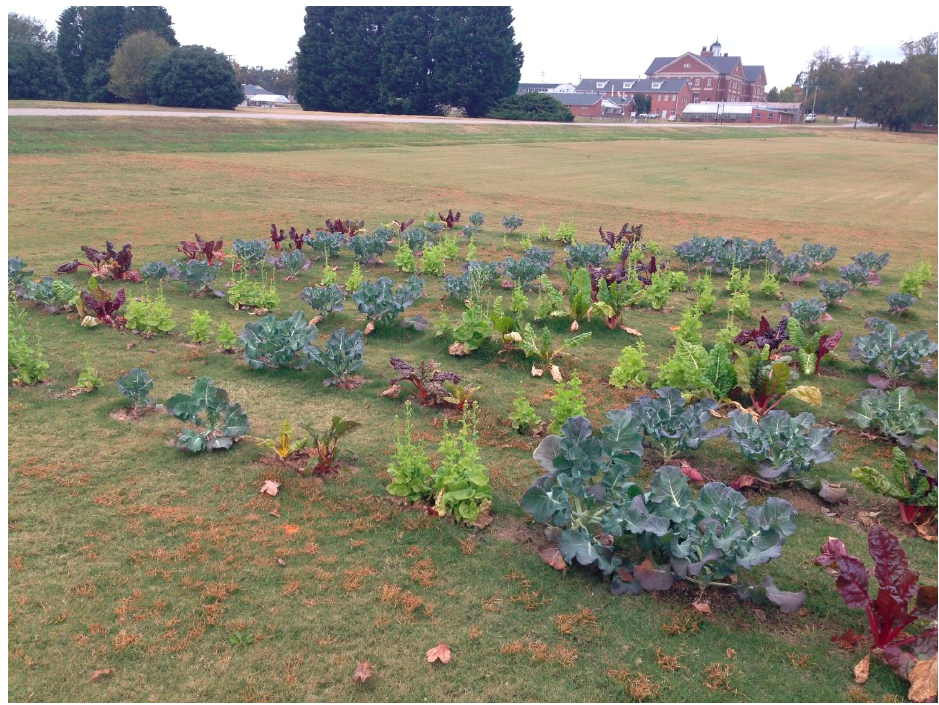
Figure 3. Vegetable field trial in November, 2014.